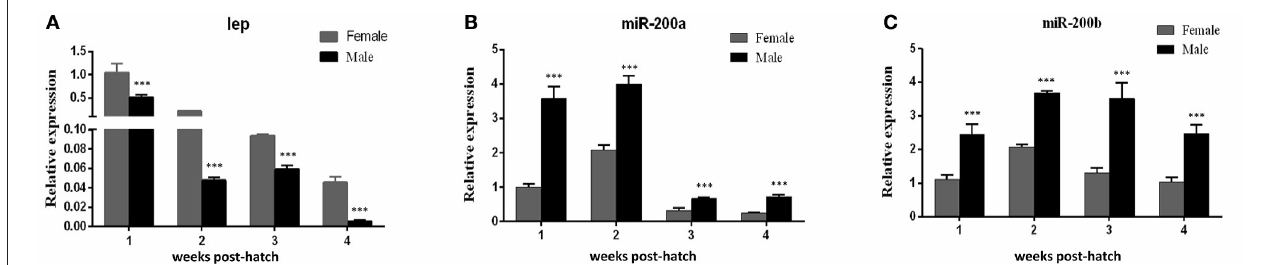
FIGURE 6 | Different effects of MT on the expression of lep and miR200a/b mRNA during juvenile growth between male and female yellow catfish. (A–C) showed the effects of MT on the expression of lep (A) and miR-200a (B) and miR-200b (C) mRNA in male and female juvenile yellow catfish, respectively. The asterisk indicates the significant differences of gene expression between the females and males (*** P < 0.001).